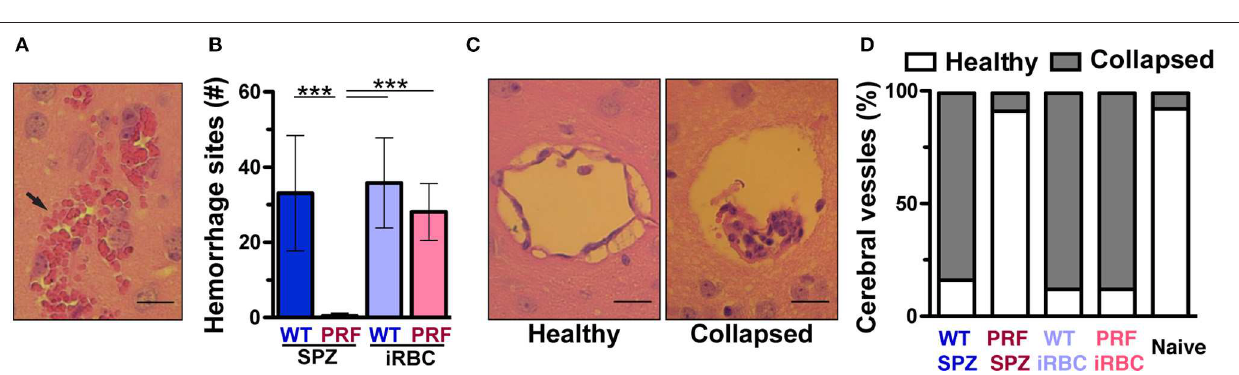
FIGURE 3 | Cerebral vessels from mice infected by PRF sporozoites maintain a healthy status. (A) Hematoxilin and eosin (H&E) stain of a brain tissue section from an animal displaying signature ECM symptoms. An arrow indicates RBCs that leaked into the cerebral parenchyma. Scale bar, 10 µ m. (B) Quantification of hemorrhage sites based on H&E stains of horizontal cross-sections of the brain ( n = 10 each). Results represent mean values ( ± SD) from at least two independent experiments. *** P < 0.001 (Mann-Whitney test). (C) Visualization of brain vessel integrity. Shown are H&E stains of representative brain histological cross-sections. Comparison of a healthy vessel (left) from a mouse infected with PRF sporozoites and a collapsed vessel (right) from a mouse infected with WT sporozoites. The latter vessel also contains accumulated leukocytes. Scale bar, 10 µ m. (D) Morphological scoring of cerebral vessels based on histological sections. Quantification of mice infected with 5,000 WT sporozoites, PRF sporozoites, WT iRBCs or PRF iRBCs ( n = 10 animals for infected groups, n = 3 mice for naïve group; > 20 cerebral vessels were quantified for each animal).